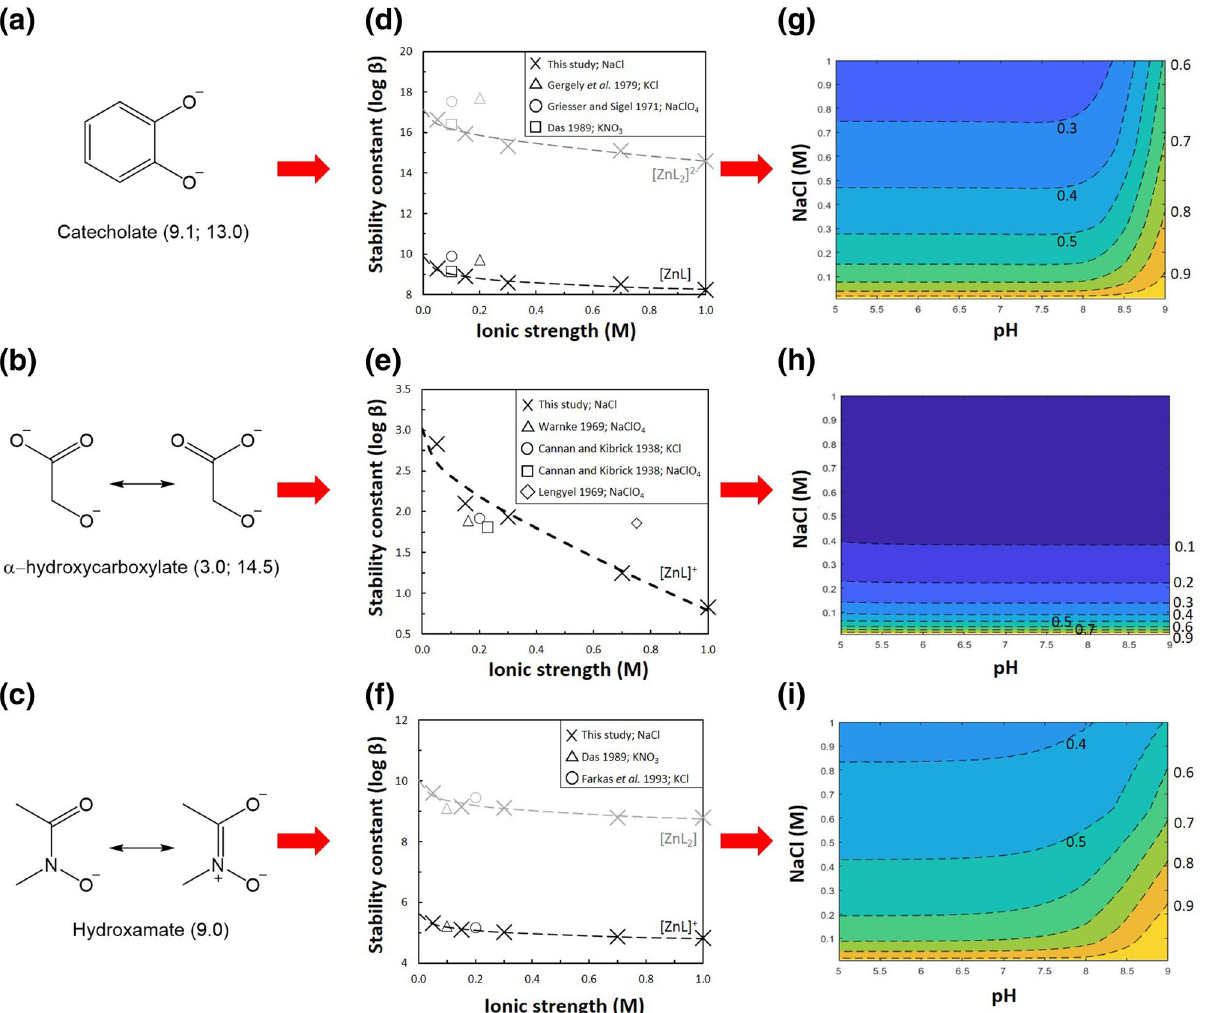
Figure 1. ( a–c ) Three major bidentate components of siderophores (approximate pK a values). ( d- f ) Experimental zinc(II)-ligand stability constants for ( d ) pyrocatecholate, ( e ) glycolic acid, and ( f ) acetohydroxamic acid in NaCl at T = 298.1 K. For each species, the modified Extended Debye–Hückel model has been parameterised using experimental data from this study and is shown as a dashed line. Literature data at T = 298.1 K is included in the figure for comparison 50–58 . Complete set of analytical results for the zinc(II)/ ligand systems, including stability constants for hydrolysed zinc(II)-ligand species, reported in Table S1. ( g-i ) Zinc(II) binding efficiency contour plots for (g) pyrocatecholate, (h) glycolic acid, and (i) acetohydroxamic acid. A zinc(II) binding efficiency value is calculated for any given pH/salinity condition by normalizing the fraction of zinc(II) complexed under these conditions, by the fraction of zinc(II) complexed by the ligand in a